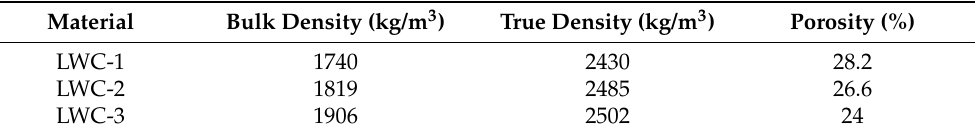
Table 2. Density and porosity of